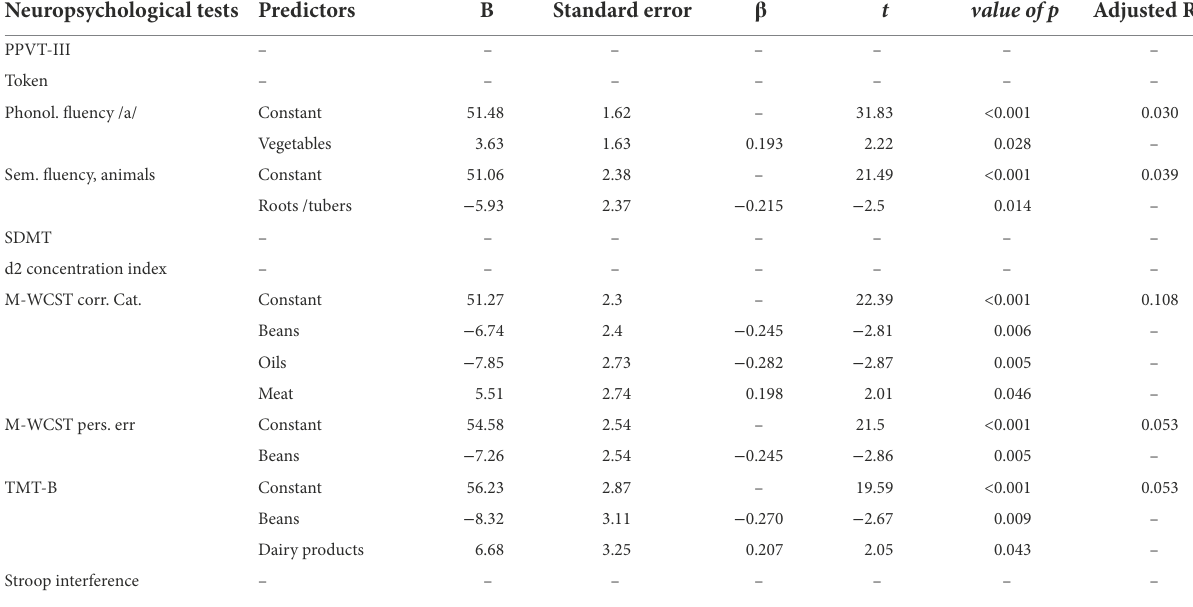
TABLE 5 Multivariate regression analyses predicting performance in 10 neuropsychological tasks based on food security (ELCSA). Neuropsychological tests